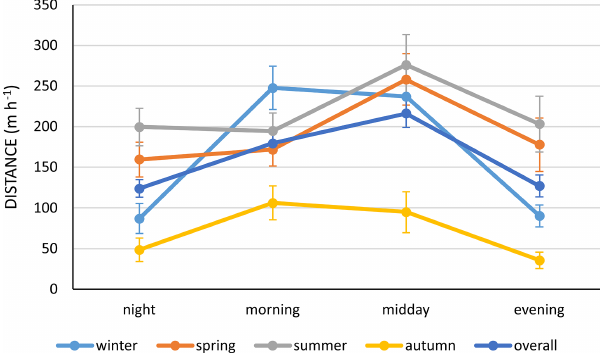
Figure 2. The mean distance (mh − 1 ) travelled by Polish Konik horses during different times of the day and